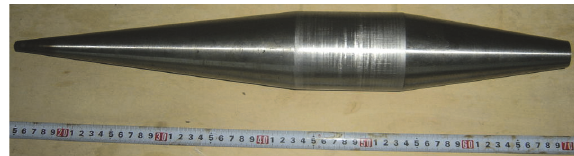
Figure 1: Striker of SHPB measurement equipment ( 𝜑 , 50 mm).